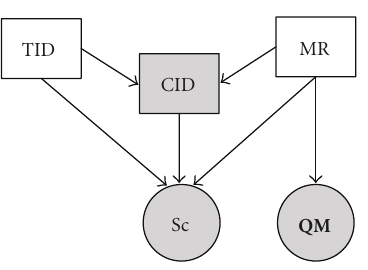
Figure 1: Bayesian network for modality decision reliability estima-